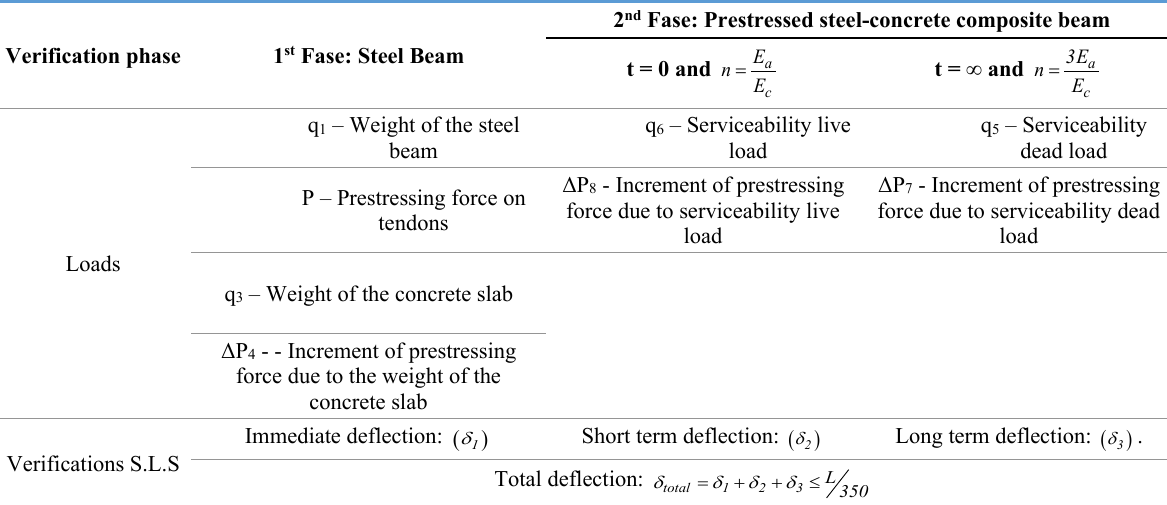
Table 4. Verification phases of Prestressed steel-concrete composite beam –